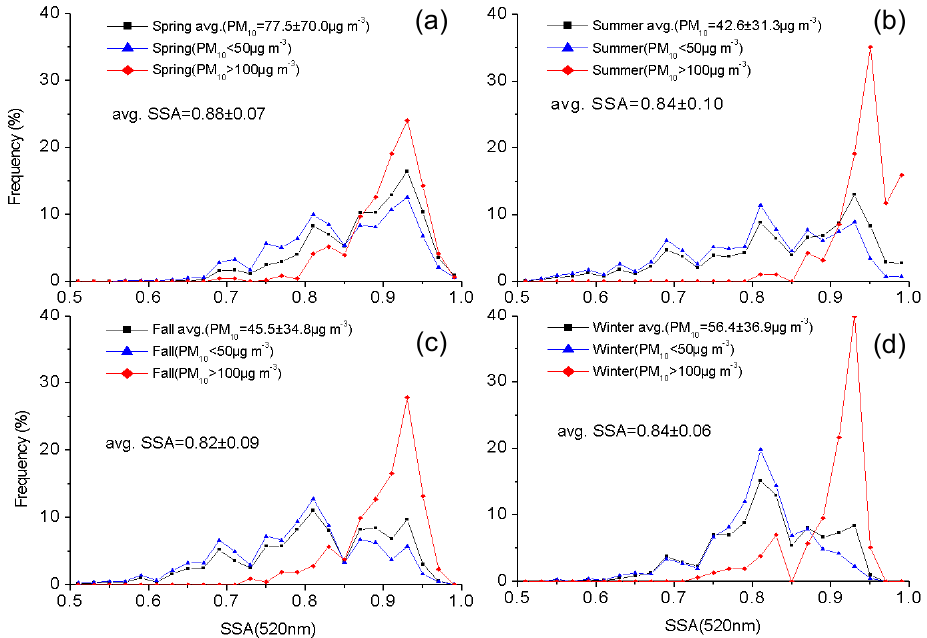
Fig. 9. Frequency distributions of SSA at 550nm during (a) spring, (b) summer, (c) fall, and (d) winter, respectively. Blue triangle and red diamond represent relatively clean (PM 10 < 50µgm − 3 ) and polluted (PM 10 > 100µgm − 3 ) periods, respectively.